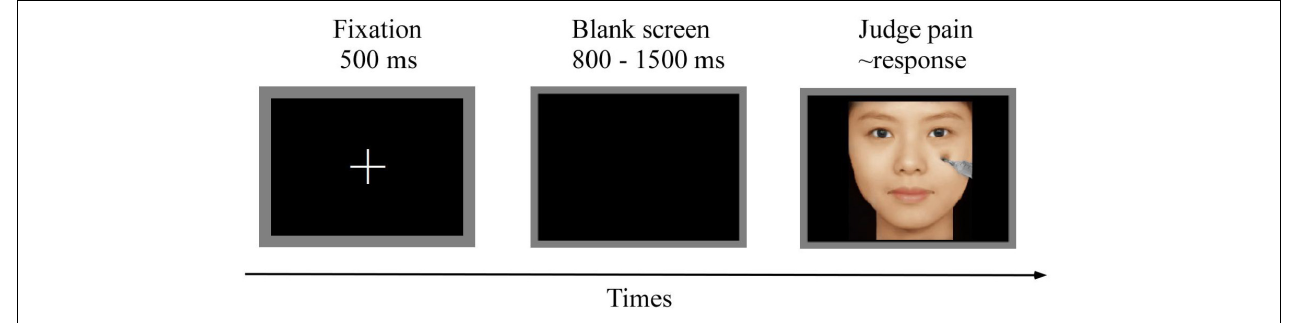
FIGURE 2 | Flowchart describing the procedure of the